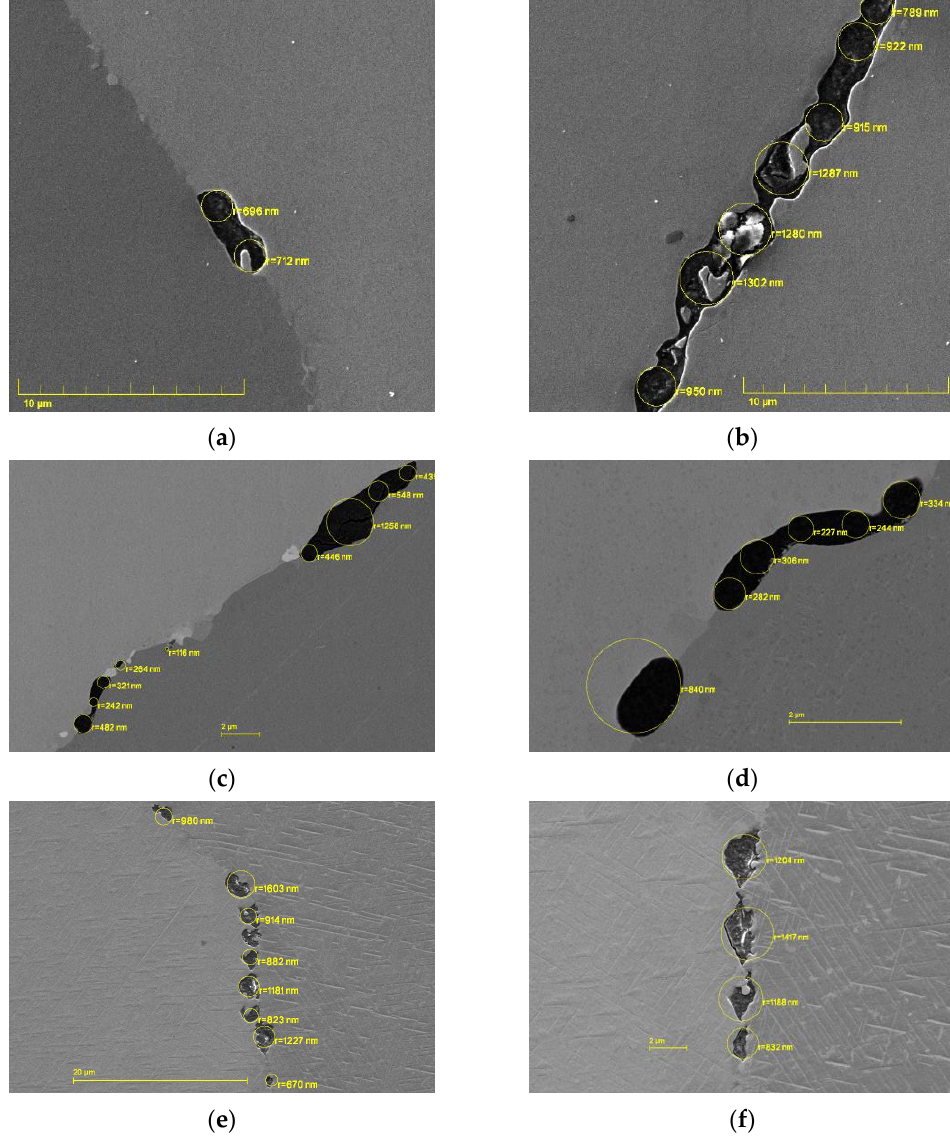
Figure 5. SEM images of cavities at grain boundaries in specimens 31 ( a , b ), 33 ( c , d ) and 75 ( e , f ).